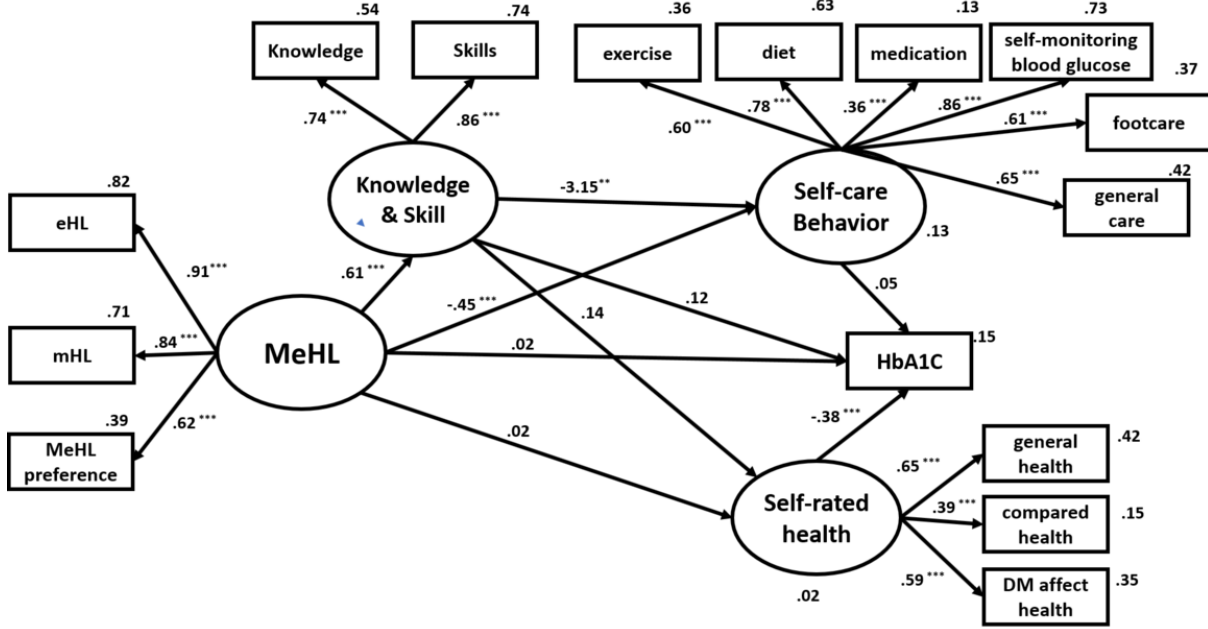
Figure 1. The mobile eHealth literacy (MeHL) model that was first tested. DM: diabetes mellitus; eHL: eHealth literacy; HbA 1c : glycated hemoglobin; mHL: mobile health literacy.* P =.01-.05, ** P =.001-0.01<.01, *** P